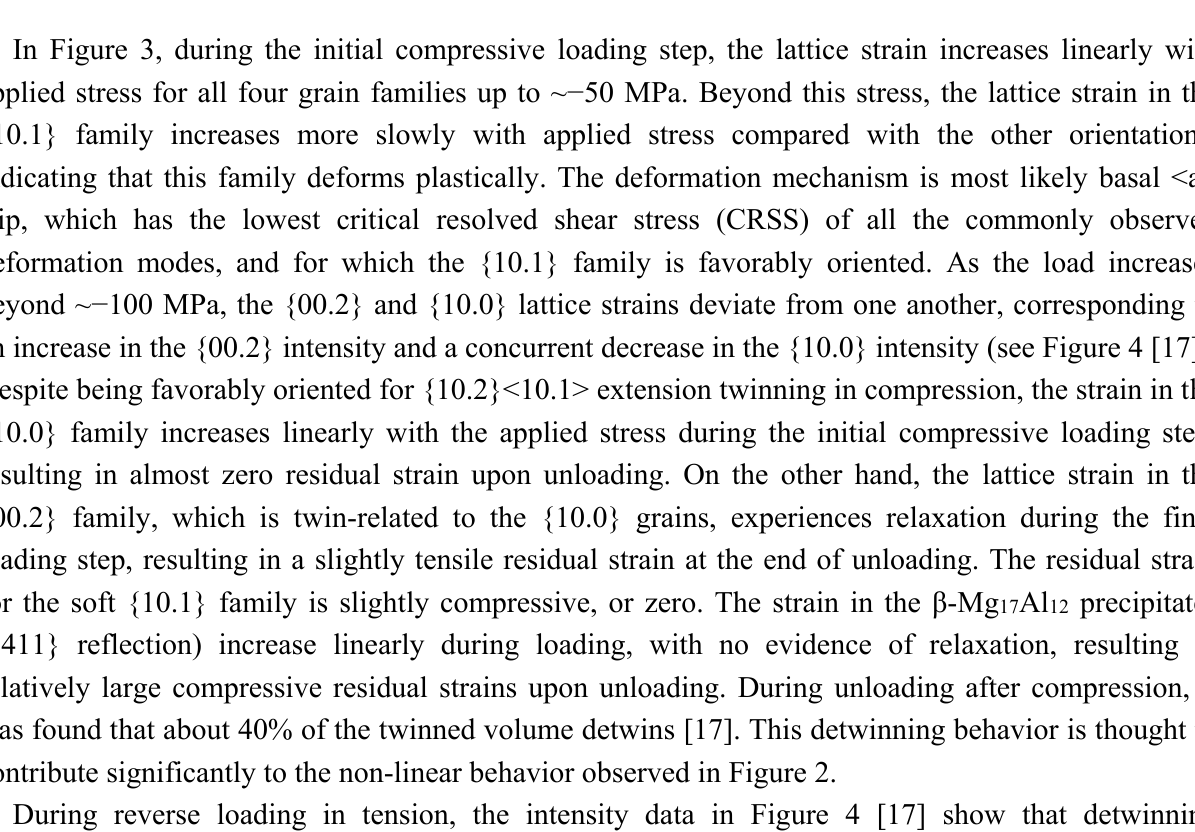
Figure 4. Intensity variations for various grain families as a function of applied stress during the deformation shown in Figure 2